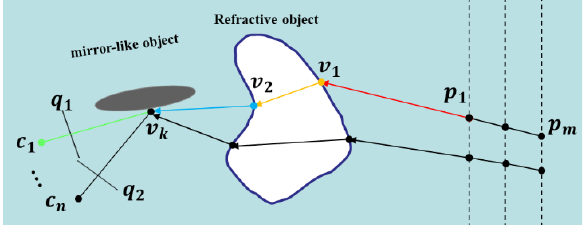
Figure 4. The geometry of N-K-M triangulation expressed by Kutulakos et al. (2008). To reach point q on the image plane, the light path from p crosses three surfaces, including refractive and mirror-like ones, passing from three vertices, v1, v2, and v3, which form four segments. The objective of light-path triangulation is to estimate the normals and coordinates of the vertices using the known coordinates of c, q and p.